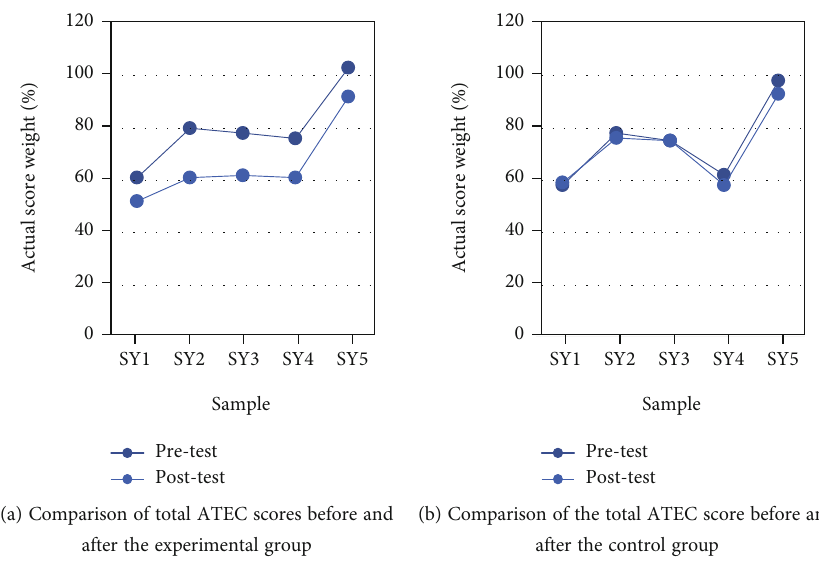
Figure 4: Visual diagram of the comparison of the total ATEC score before and after the test group and the control group. Table 1: Sign-rank sum test results of ATEC total scores of children in experimental group. N Rank mean Rank sum Z Asymptotic signi fi cance